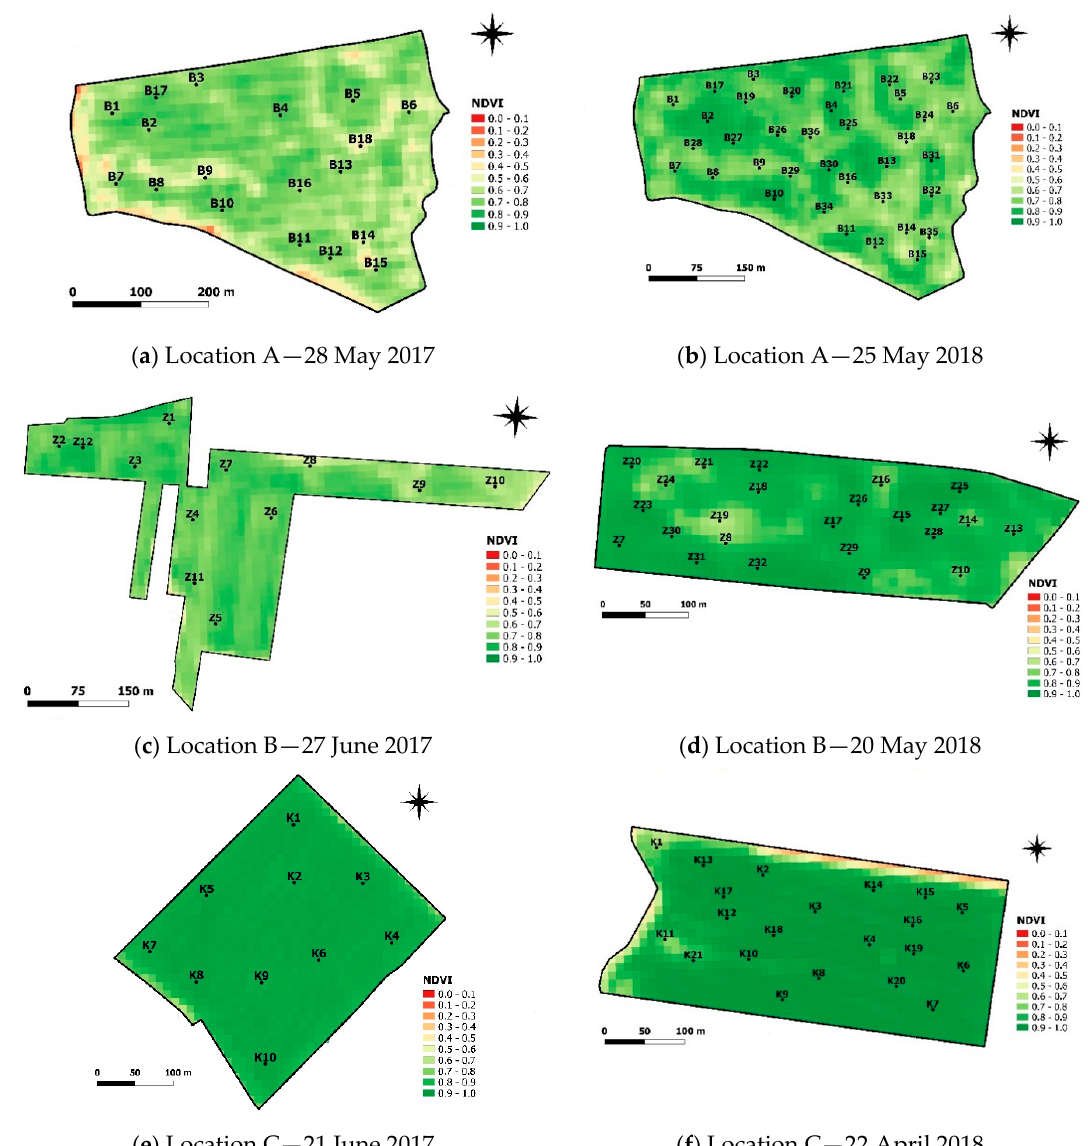
Figure 3. Normalized Difference Vegetation Index (NDVI) maps of the experimental fields in three locations ( a , b : Bro ż ówka—A, c , d : Zdziechów—B, and e , f : Kry ł ów—C) in two seasons: 2017 (on the left) and 2018 (on the right), from dates when maximum average value of this index was achieved, with soil and plant sampling points superimposed. Explanation of color representation of NDVI values and the dates of NDVI acquisition are given.